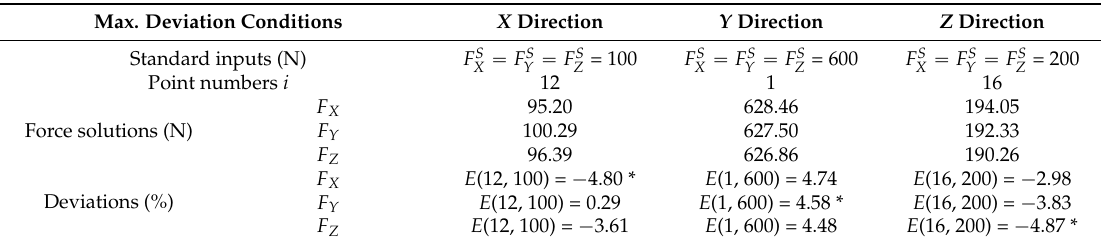
Table 4. The maximum deviations of solved forces in different